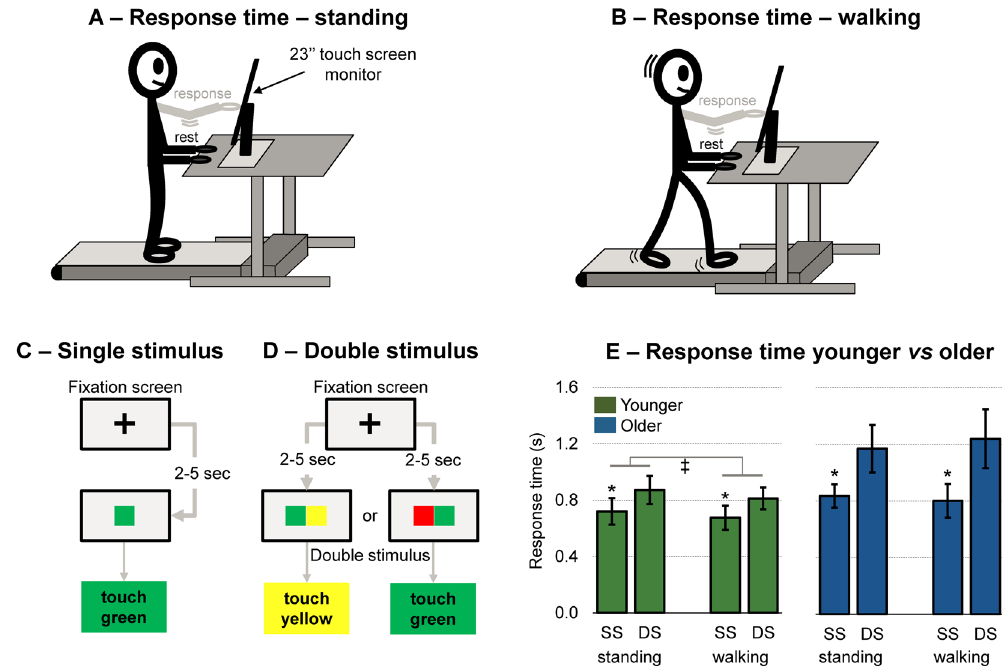
Figure 2. Experimental protocol to test cognitive-motor interference in different postures. Participants were asked to stand (panel A) or walk at preferred speed (panel B) with their hands resting on a desk. A touch- screen monitor was placed on the desk at a reachable arm distance. A computer-controlled cognitive paradigm involved the appearance of a fixation cross in the middle of the screen from 2 to 5 seconds intervals (randomly selected). In the single stimulus condition (SS, panel C) a single green square appeared replacing the fixation cross, and participants should touch inside the area of the square as fast as possible with their dominant hand. In the double stimulus condition (DS, panel D), a pair of green + yellow or red + green squares appeared replacing the fixation cross. If the pair of squares were green + yellow, participants should touch inside the yellow square. If the pair of squares were red + green, participants should touch inside the green square. In the panel E, mean ± SD response time for the standing single stimuli, standing double stimuli, walking single stimuli and walking double stimuli. ‡ Denotes significant difference in relation to walking condition in the same group (p < 0.005); * denotes significant difference in relation to double stimulus condition in the same group (p <